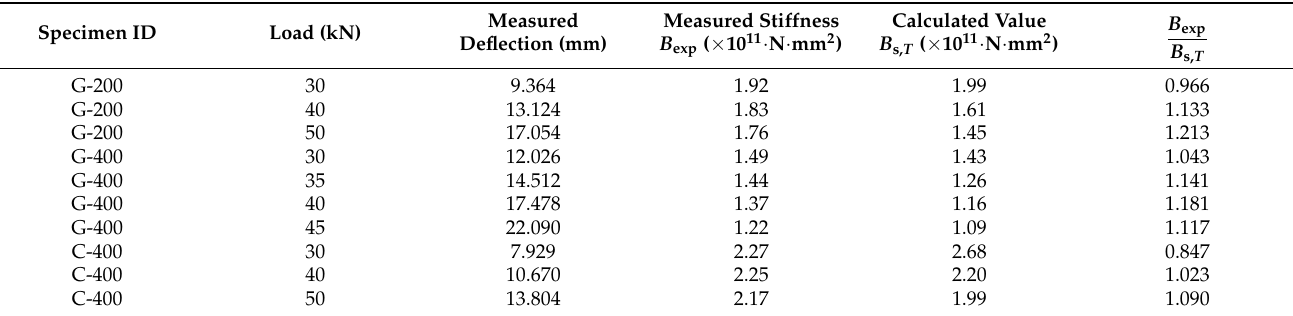
Table 8. Comparison between measured and calculated values of short-term stiffness B s, T of tested beam specimens after high-temperature